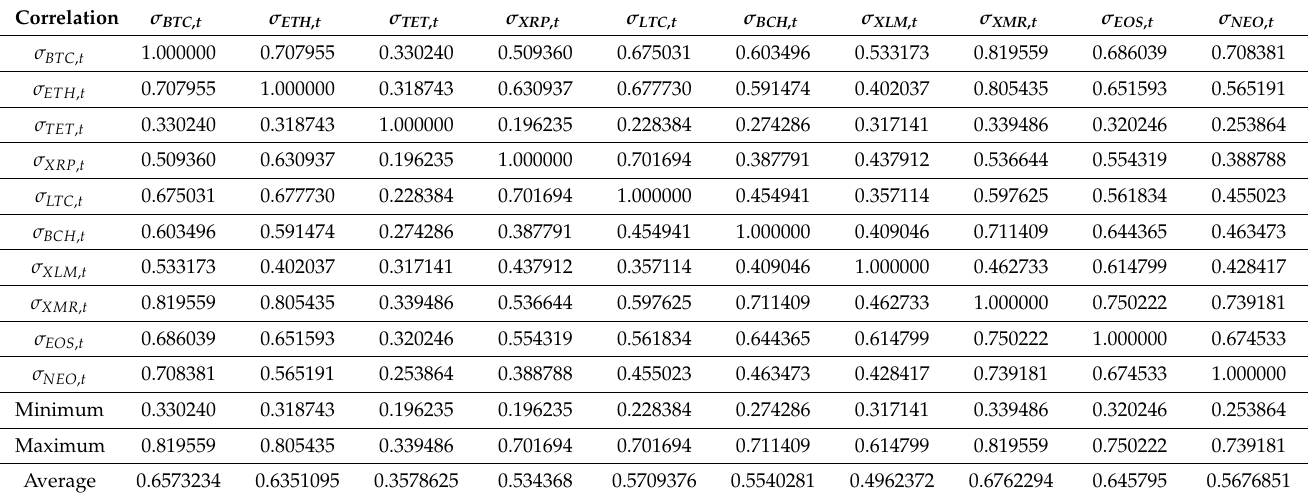
Table 11 lists the results of the correlations among the varying GARCH values of the 10 cryptocurrencies’ return indices for the pre-COVID-19 period. Table 11. Correlations among the varying GARCH values of the 10 cryptocurrencies’ return indices for the pre-COVID-19 period.